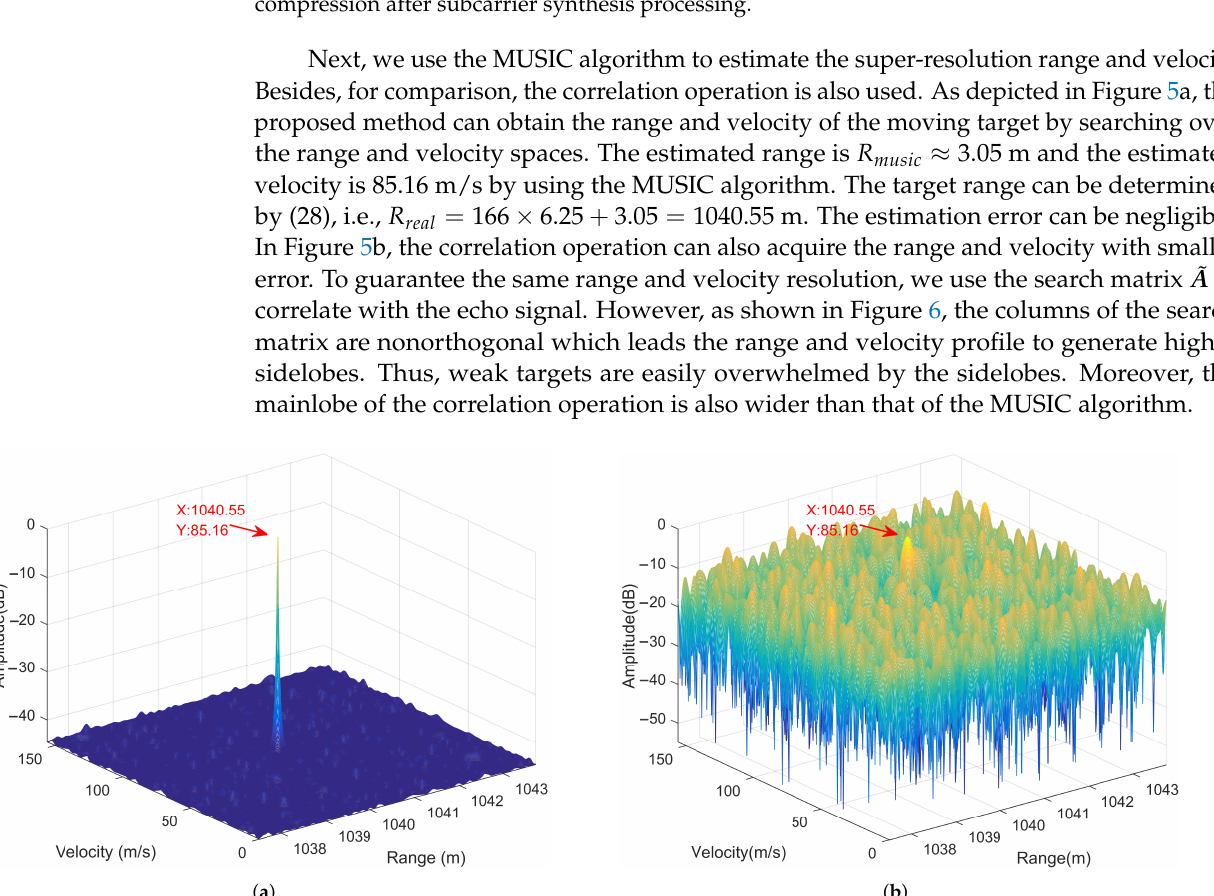
Figure 4. ( a ) The result of subcarrier synthesis processing in the time–frequency domain. ( b ) Pulse compression after subcarrier synthesis processing.